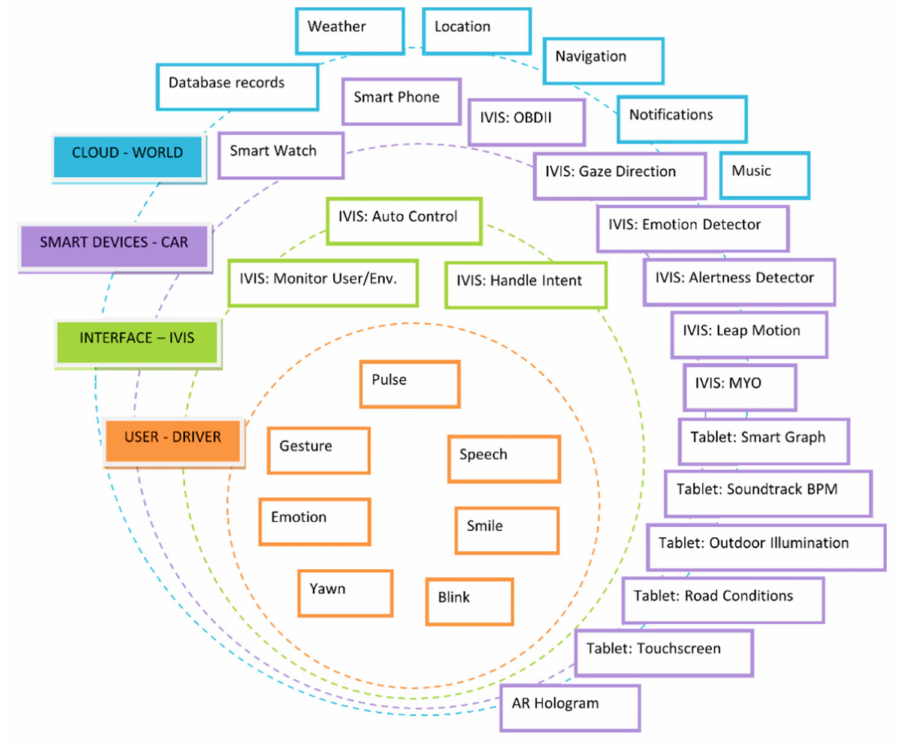
Figure 2. Intelligent driving environment